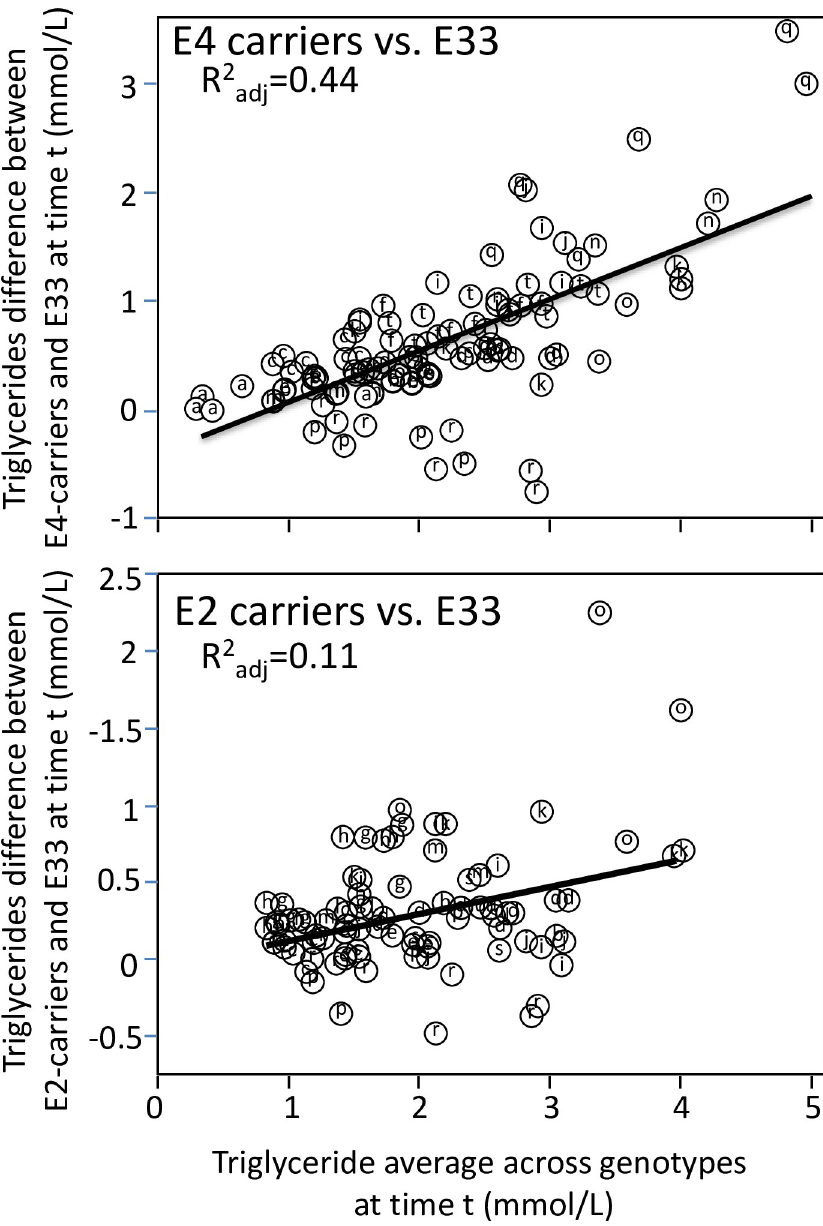
Fig 2. Quantile-dependent expressivity plots for postprandial triglyceride responses by APOE genotypes. Quantile-dependent expressivity showing increasing genetic effect of apo E4- and E2-carriers vs. E33 homozygotes with increasing average triglyceride levels. Data estimated from the published excursion plots from 10,876 measurements in E33, 4682 measurements in E4-carriers, and 2311 measurements in E2-carriers. Point source coded as follows: a) Bergeron et al. [7], b) Boerwinkle et al. [9], c) Brown et al. [11], d) Carvalho-Wells et al. [18], e) Dallongeville et al. [22], f) Dart et al. [23], g) Erkkila et al. at 8 weeks [30], h) Erkkila¨ et al. at baseline [30], i) Ferreira et al. for intensive training [32], j) Ferreira et al. for moderate training [32], k) Ferreira et al. for sedentary activity [32], l) Irvin et al. post-treatment [51], m) Irvin et al. pre-treatment [51], n) Kobayashi et al. [60], o) Nikkila¨ et al. cases [85], p) Nikkila¨ et al. controls [85], q) Reiber et al. [103], r) Reznik et al. [104], s) Vansant et al. [122], and t) Wolever et al.